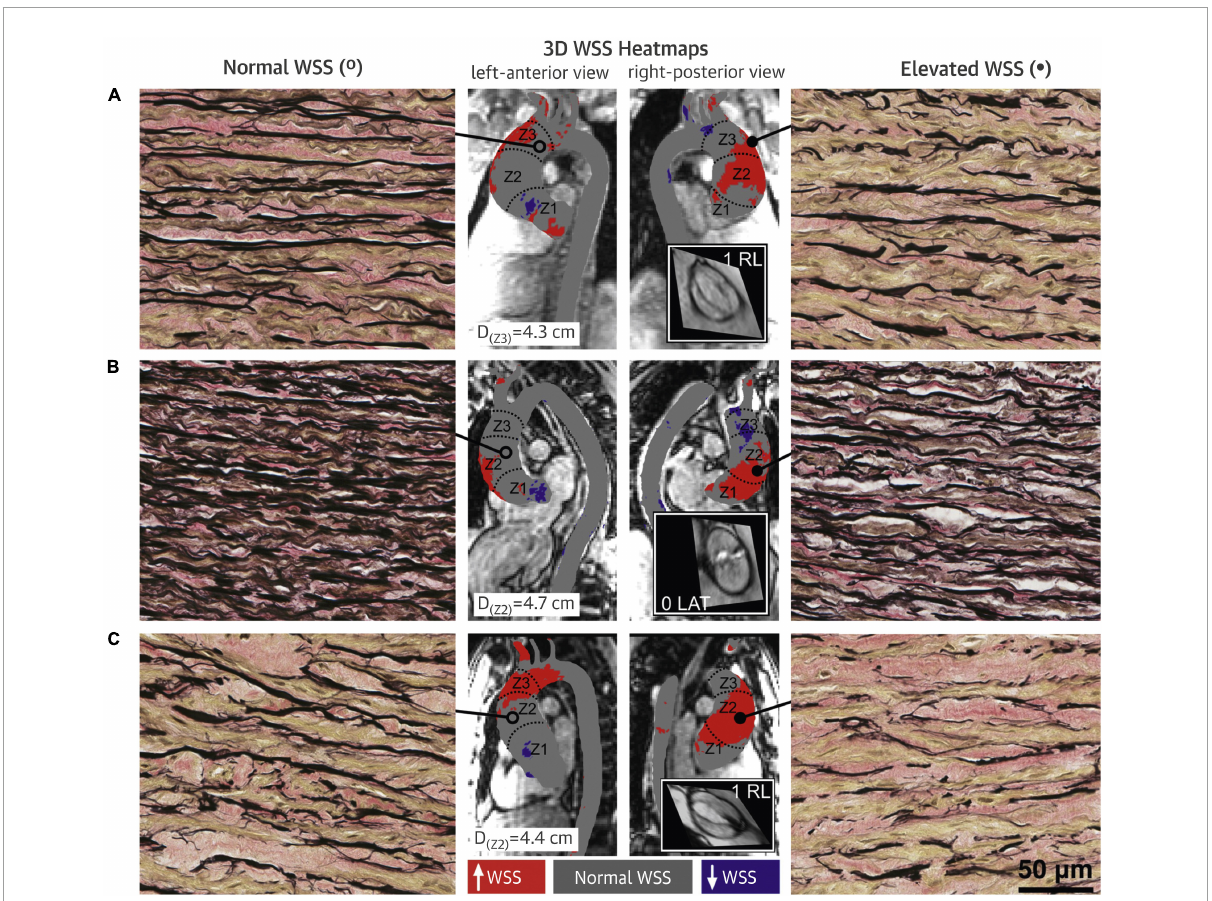
FIGURE8 Bicuspid aortic valve (BAV) aorta wall shear stress (WSS) heatmaps and histopathology samples with elastin fiber staining. (A–C) Denote three different BAV aortas. Regions with elevated WSS (right panels) had fewer, thinner and more sparsely distributed elastin fibers (black) compared to regions with normal WSS (left panels). Central panels show the WSS distribution on the ascending aorta (AAo) with gray denoting normal WSS within the 95% confidence interval compared with a healthy tricuspid aortic valve population, and red and purple denoting elevated and decreased WSS, respectively (37). Permission to reproduce obtained from